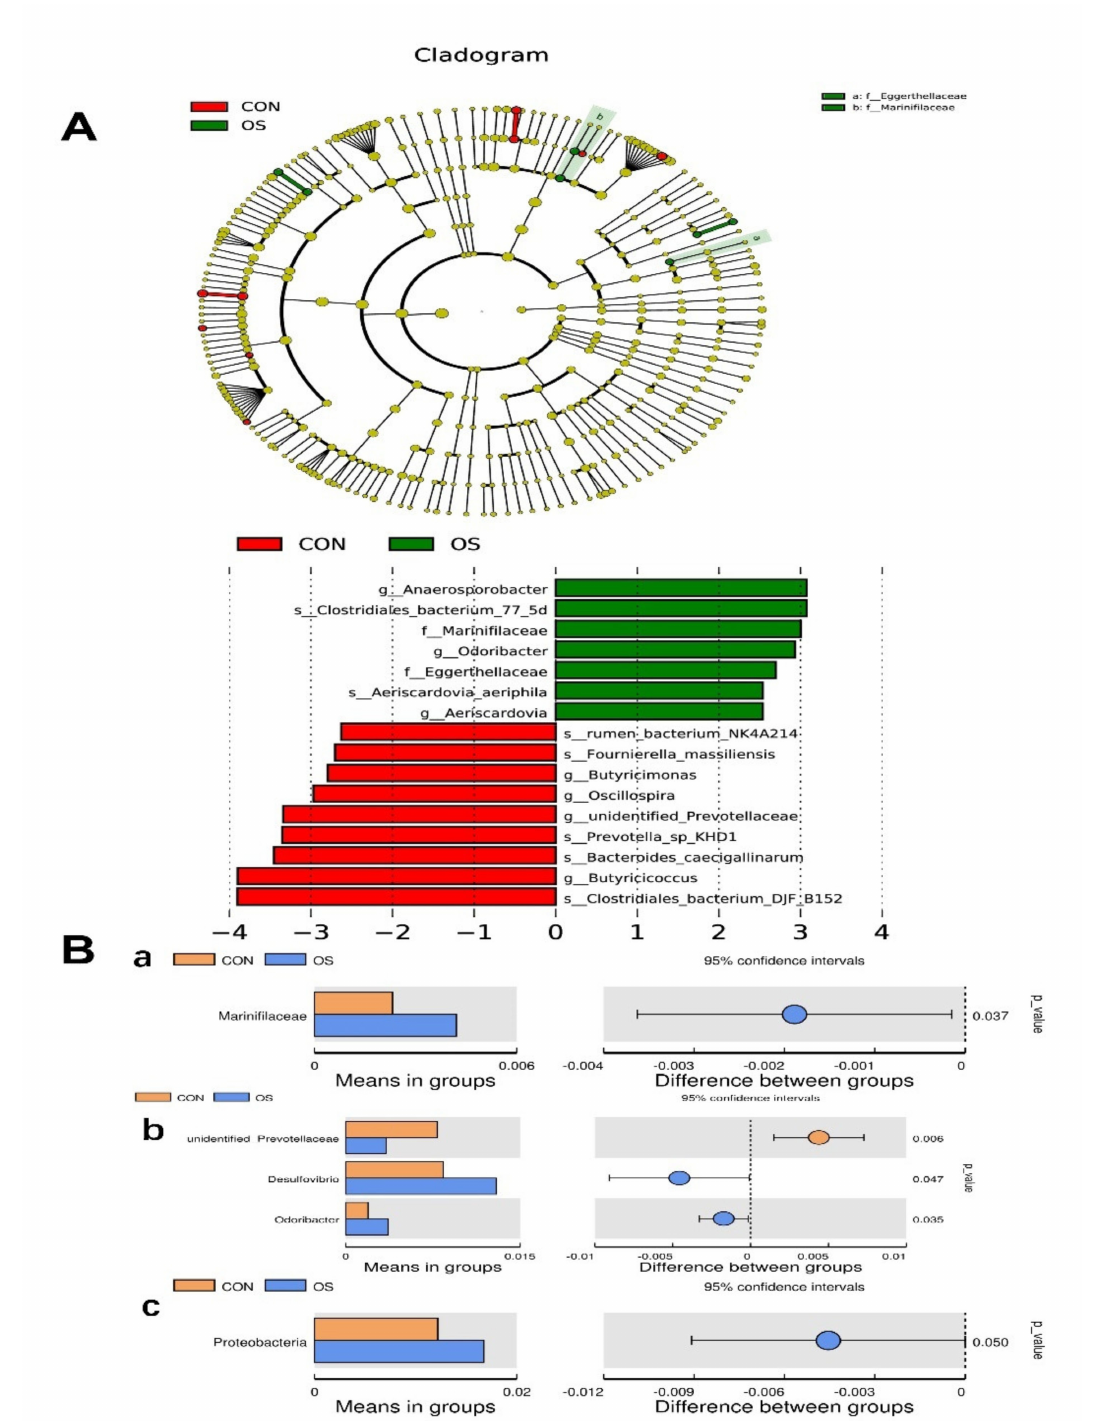
Figure 6. Oxidative stress (induced by tBHP) changed microbiota enrichment (Experiment 1). Data are means ± SEM represented by vertical bars or plot individual values. ( A ) Linear discrimination analysis coupled with effect size (LEfSe) identified most differentially abundant taxa in the cecum with LDA significant threshold > 3 were shown. (Red) CON enriched taxa; (Green) OS enriched taxa. ( B ) Analysis of different species between groups at different levels. ( a ) Family, ( b ) Genus, ( c ) Species. The difference n = 10. Statistical significance was evaluated by the Student’s t